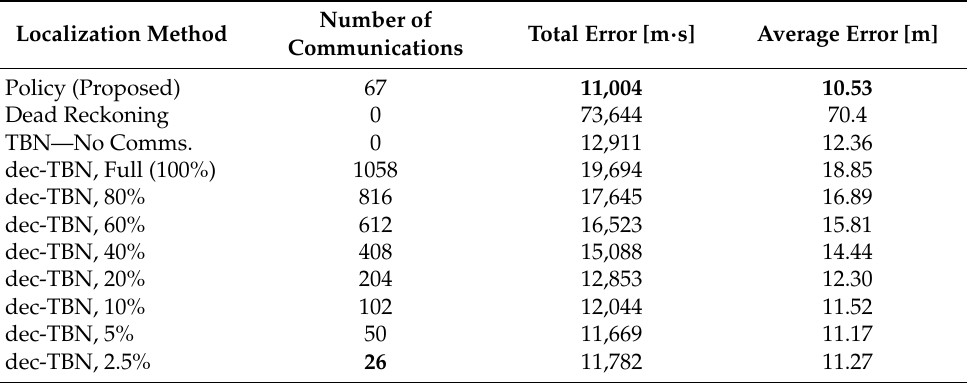
Table 3. Localization methods, communication bandwidth and total joint error for 2 AUVs over the course of a 1.5 km track.